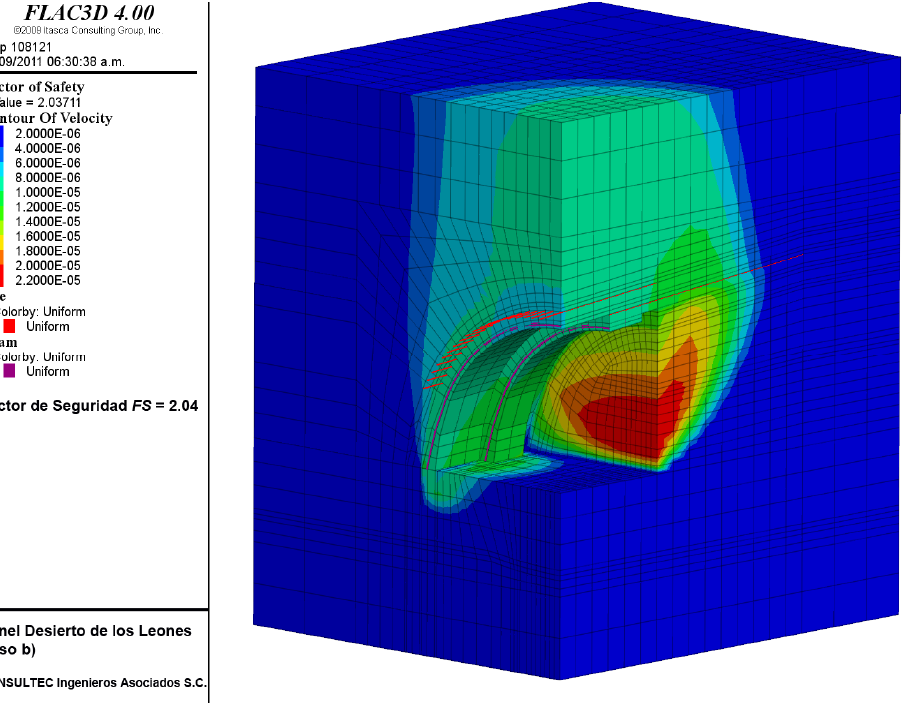
Figure 37. Potential mechanism of instability for case (b): shallow excavation in the South Portal area (Tobas and Pomez) with minimal parameters. Definition: Caso (b) (case b), Factor de Seguridad (safety factor).